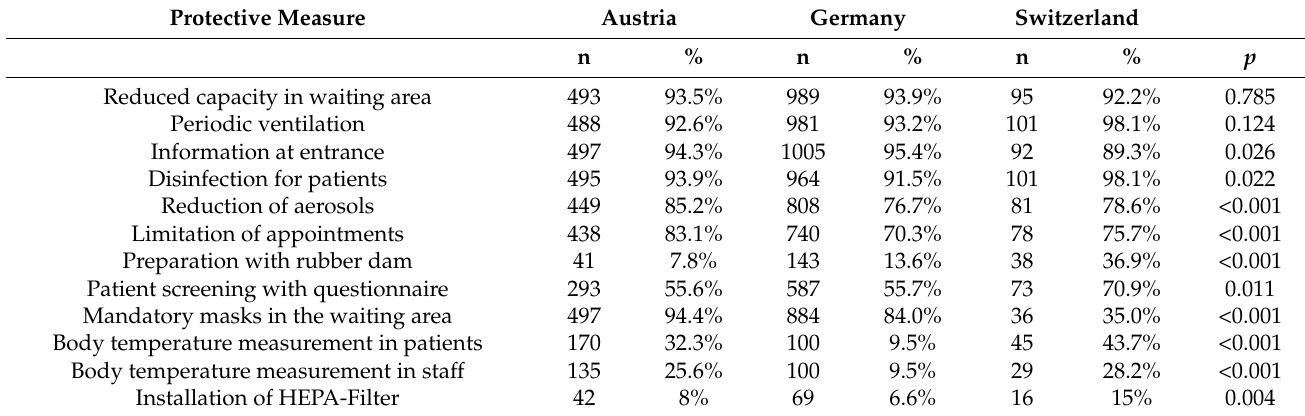
Table 2. Protective measures integrated into daily routine during the first COVID-19 lockdown in Austria, Germany, and